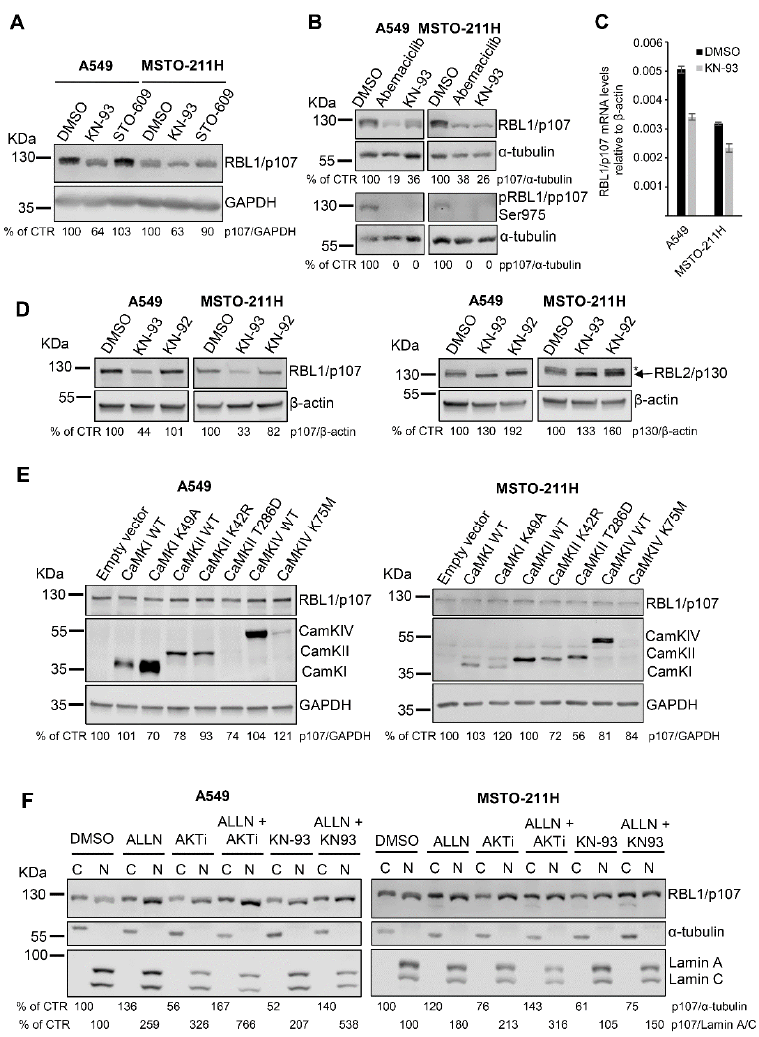
Figure 4. The CaMK inhibitor KN-93 reduces RBL1/p107 levels in A549 and MSTO-211H cells. ( A ). A549 and MSTO211H cells were treated for 16 h with the CaMK inhibitor KN-93 (20 µ M) or the CaMKK inhibitor ST-609 (20 µ M) and RBL1/p107 levels assessed by immunoblot. ( B ). A549 and MSTO-211H cells were treated with 0.2 µ M Abemaciclib or 20 µ M KN-93 for 16 h. Levels of total and phosphorylated RBL1/p107 (Ser975) were analyzed by immunoblot. ( C ). mRNA levels of RBL1/p107 relative to β -actin were assessed by qPCR in A549 and MSTO-211H treated with 20 µ M KN-93 or control for 16 h. Mean ± SD. ( D ). Protein levels of RBL1/p107 and RBL2/p130 were analyzed in A549 and MSTO211H cells treated with the CaMK inhibitor KN-93 (20 µ M) or with the inactive derivative of KN-93, KN-92 (20 µ M), for 16 h. * Indicates an unspecific band recognized by the anti-RBL2/p130 antibody. ( E ). A549 and MSTO-211H cells were transiently transfected with plasmids encoding wild type (WT) CaMKI, CaMKI kinase-inactive mutant K49A, WT CaMKII, CaMKII kinase-inactive mutant K42R, CaMKII constitutively active mutant T286D, WT CaMKIV, CaMKIV kinase-inactive mutant K75M, or an empty vector used as control. 6 h post transfection, cells were transferred in serum free-media and incubated for additional 24 h. Cells were then serum-stimulated for 16 h. RBL1/p107 levels were analyzed from cell lysates by immunoblot. CamKII was detected using an anti-CaMKII antibody, while CamKI and CaMKIV were assessed using an anti-c-myc tag antibody. ( F ). RBL1/p107 levels were analyzed in cytoplasmic (C) and nuclear (N) fractions of A549 and MSTO-211H cells pre- incubated with the calpain inhibitor ALLN (100 µ M) or a solvent control for 1 h and then incubated for 16 h with 100 µ M ALLN, 12.5 µ M AKTi VIII, 20 µ M KN-93 alone or the indicated combination. Quantification was performed by densitometric analysis using the ImageJ program and expressed as % of control. All experiments were performed three